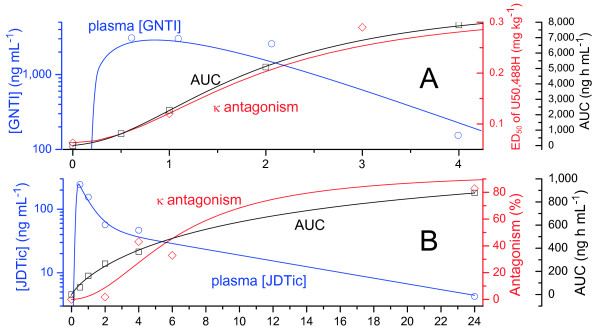
Early mean plasma levels and AUC compared to the reported timecourses of κ antagonism for GNTI(A: rhesus monkeys, 1 mg kg
-1
 i.m. [[14]]) and JDTic (B: mice, i.g. [[15]]).